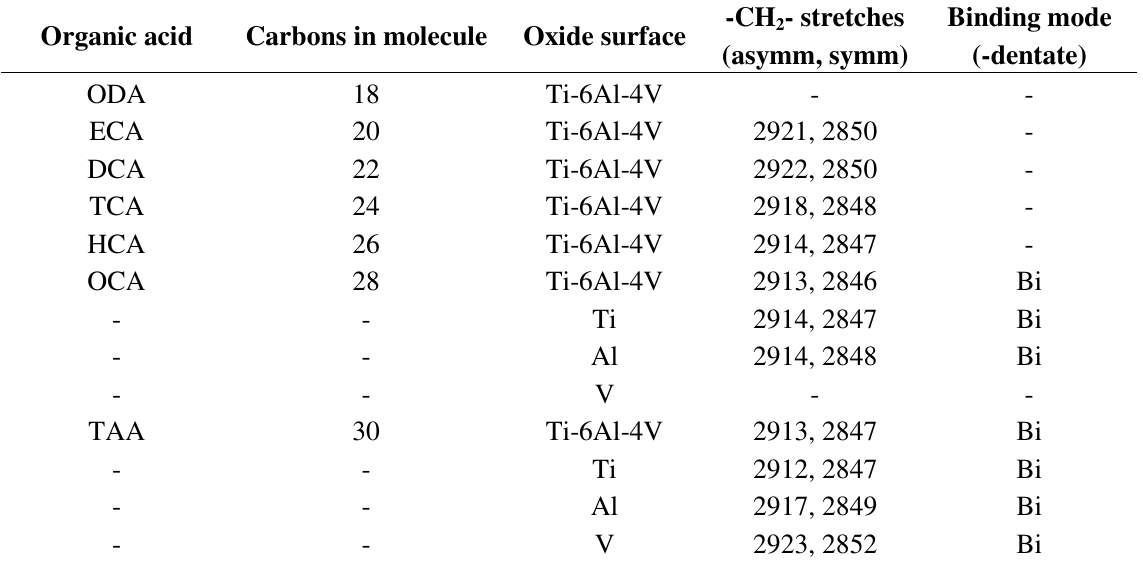
Table 1. Carboxylic Acid Modifications: Alkyl Chain Conformation and Binding Mode after